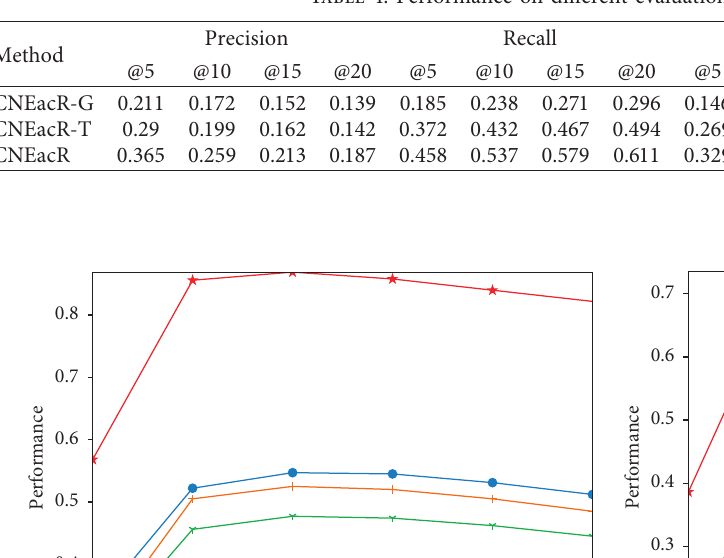
Table 4: Performance on different evaluation criteria in AMiner.